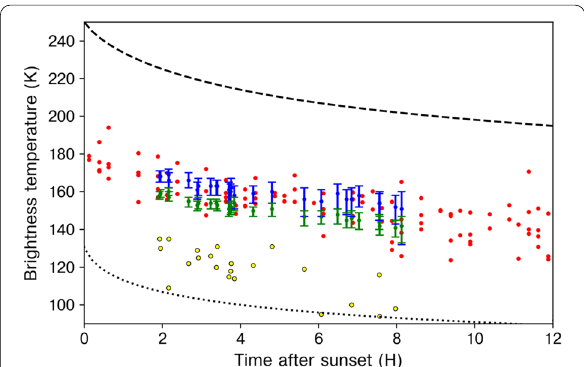
Fig. 7 The difference in brightness temperatures between bands 11 and 15. The color of each point corresponds to albedo at the wavelength of 1064 nm measured by LOLA. The red and blue shades show the range of a standard deviation in the mare and highland regions, respectively. There is no trend from 8 to 16 H due to the